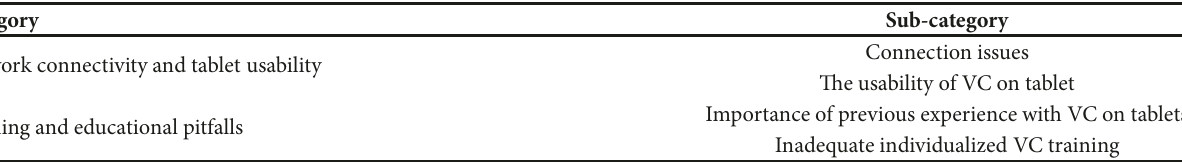
Table 1: Experiences using videoconferencing during primary